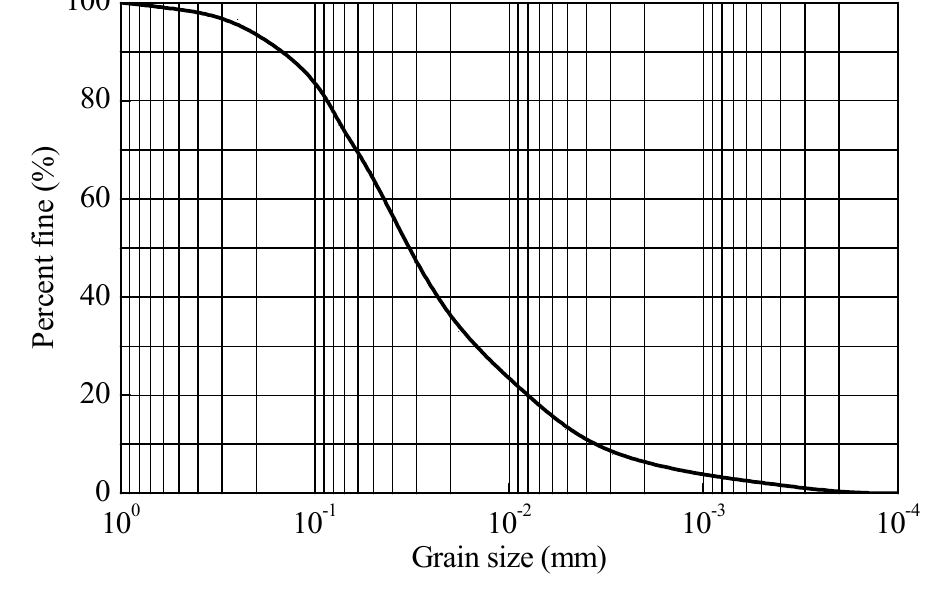
Table 1. Experimental